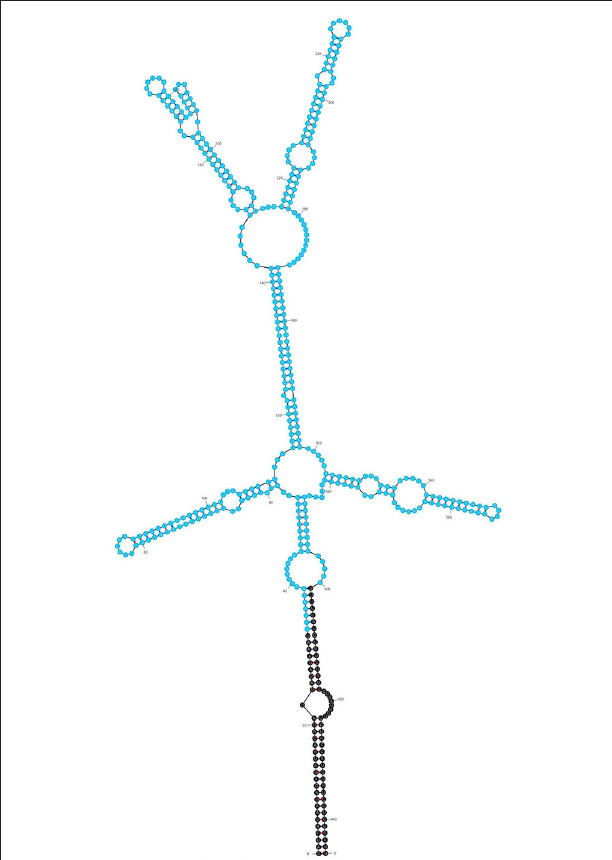
FIGURE 1 | Predicted secondary structure of the IVS using Mfold ( Zuker, 2003; 1 G = − 143.26 kCal/mol). An ORF (CBU_2096) encoding a potential S23p protein is shown in